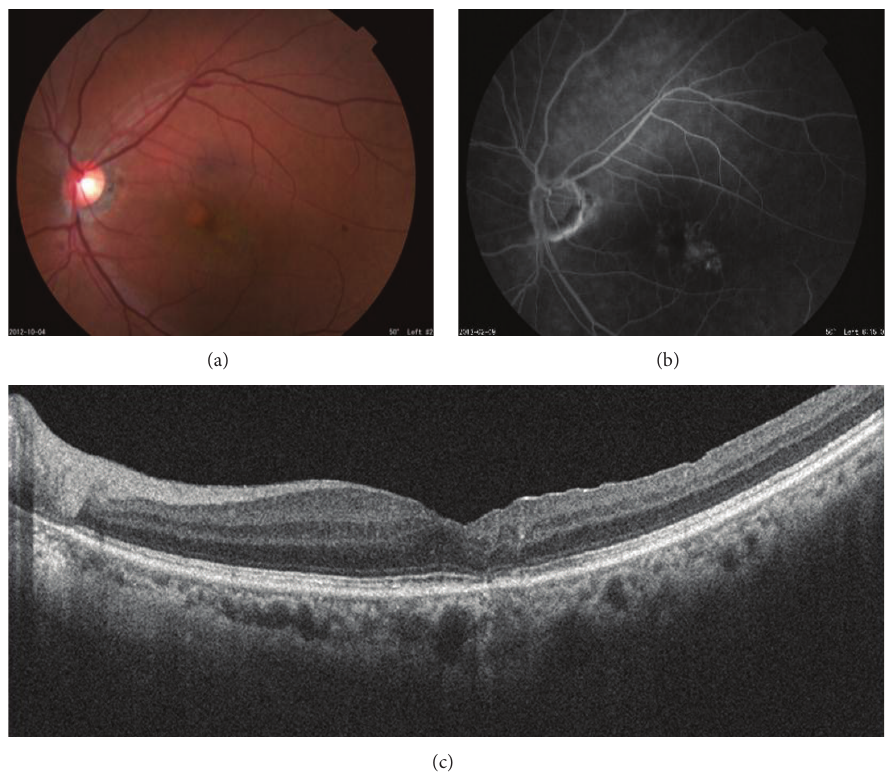
Figure 5: Fundus appearance of the left eye of Case 2 six months after surgery. Visual acuity has improved to 20/13. (a) Fundus photograph showed localized area of scarring by laser photocoagulation inferior-temporal to the fovea. (b) Fluorescein angiogram showing the disappearance of fluorescein leakage in the late phase. (c) Optical coherence tomographic image showing the absence of cystoid macular edema and restored foveal